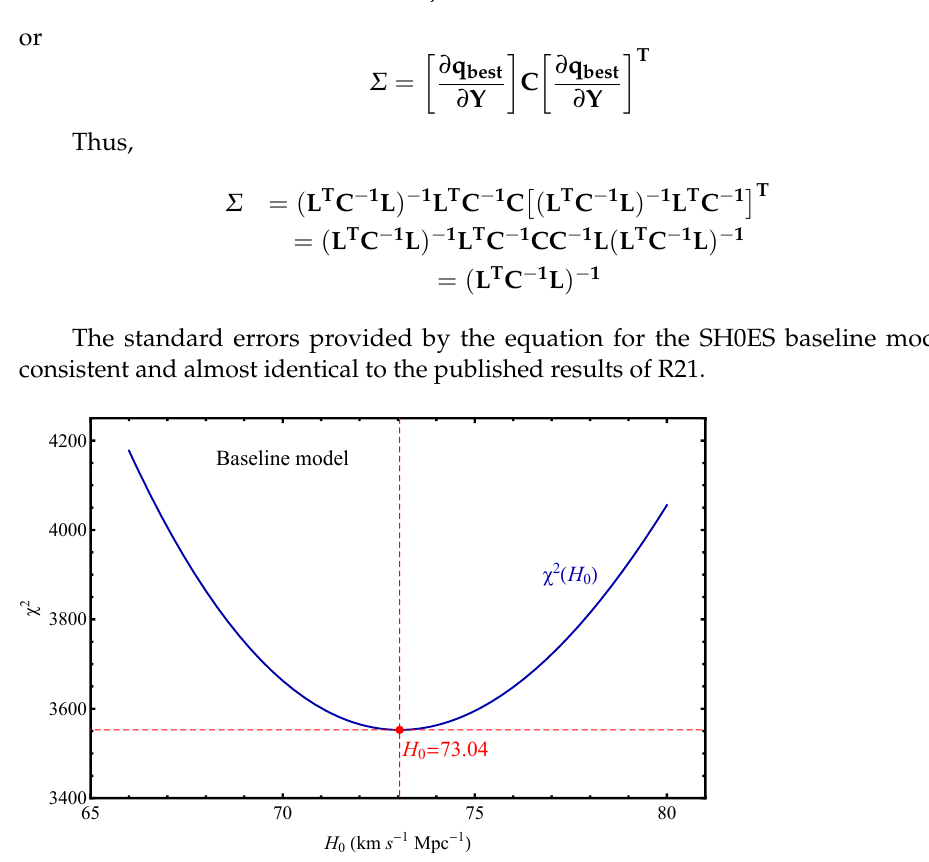
Figure A1. The form of χ 2 ( H 0 ) for the SH0ES baseline model has a minimum at the analytically predicted value of H 0 provided by (A3) (the rest of the parameters are fixed at their analytically predicted best-fit